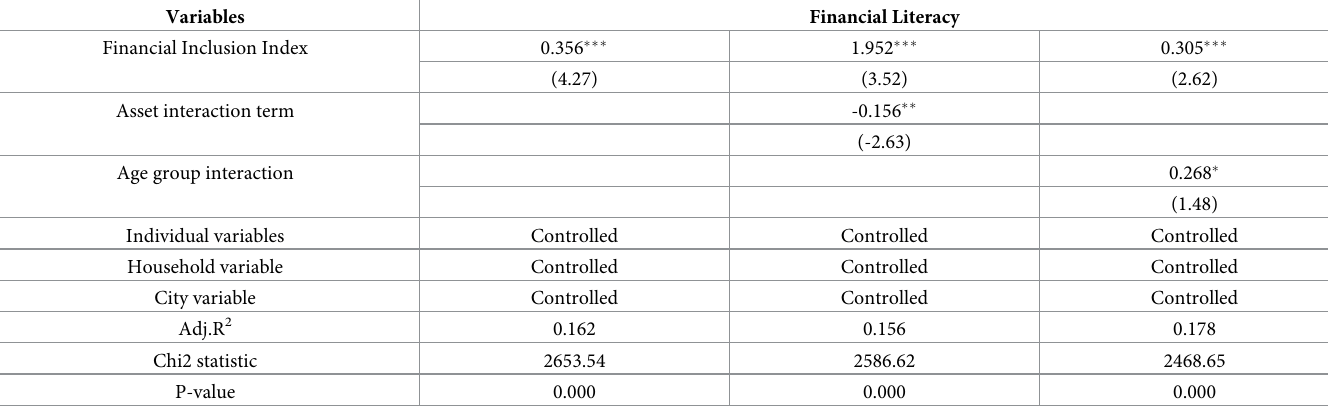
Table 3. Impact of financial inclusion development on financial